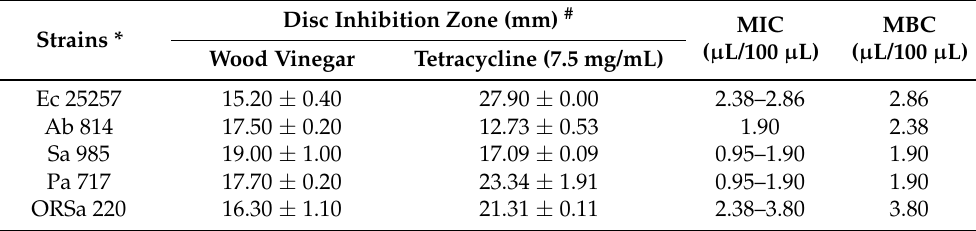
Table 2. Antibacterial activity of the wood